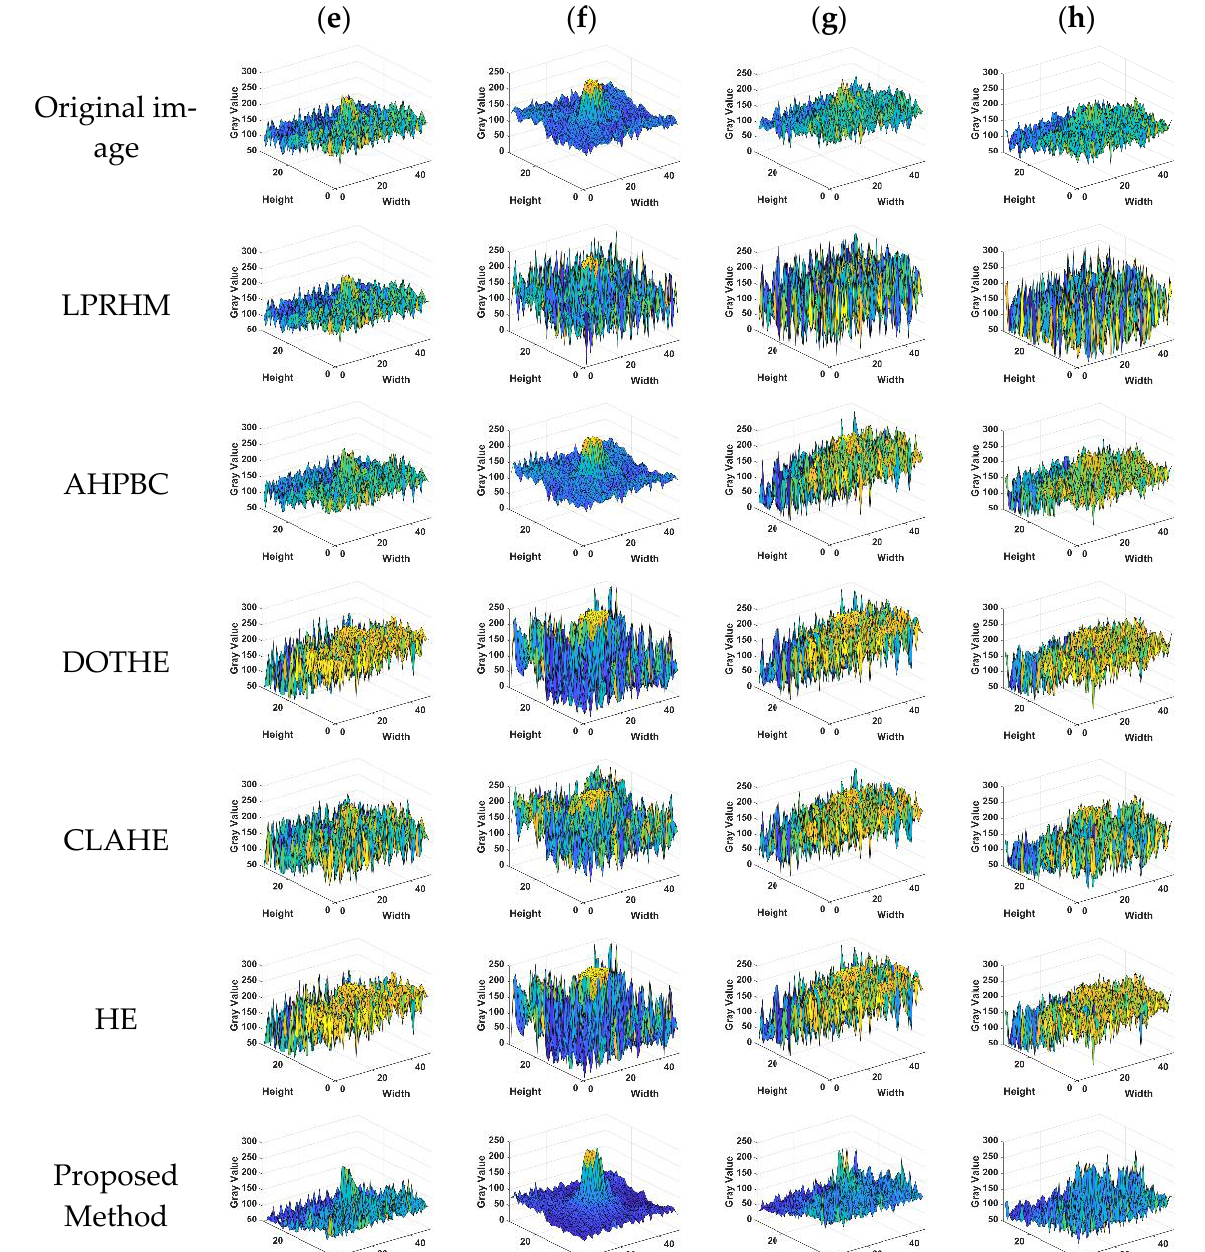
Figure 18. Grayscale image of the target area of the rough sea image. ( e – h ) are the experimental results of the rough sea image in Figure 16e–h. The first row is the target area of the original image, the second to sixth rows are the target area of the five contrasting methods, and the last row is the target area of the proposed